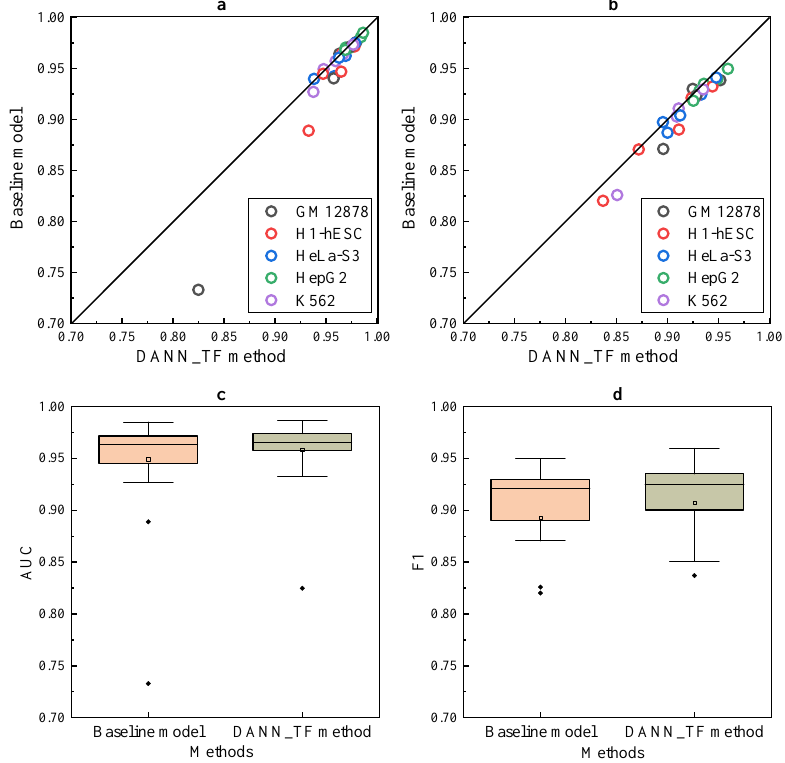
Figure 1. Performance for data augmentation. Scatter plot depicting ( a ) AUC and ( b ) F1 score of DANN_TF and the baseline method. Box plots depicting ( c ) AUC and ( d ) F1 score of DANN_TF and the baseline